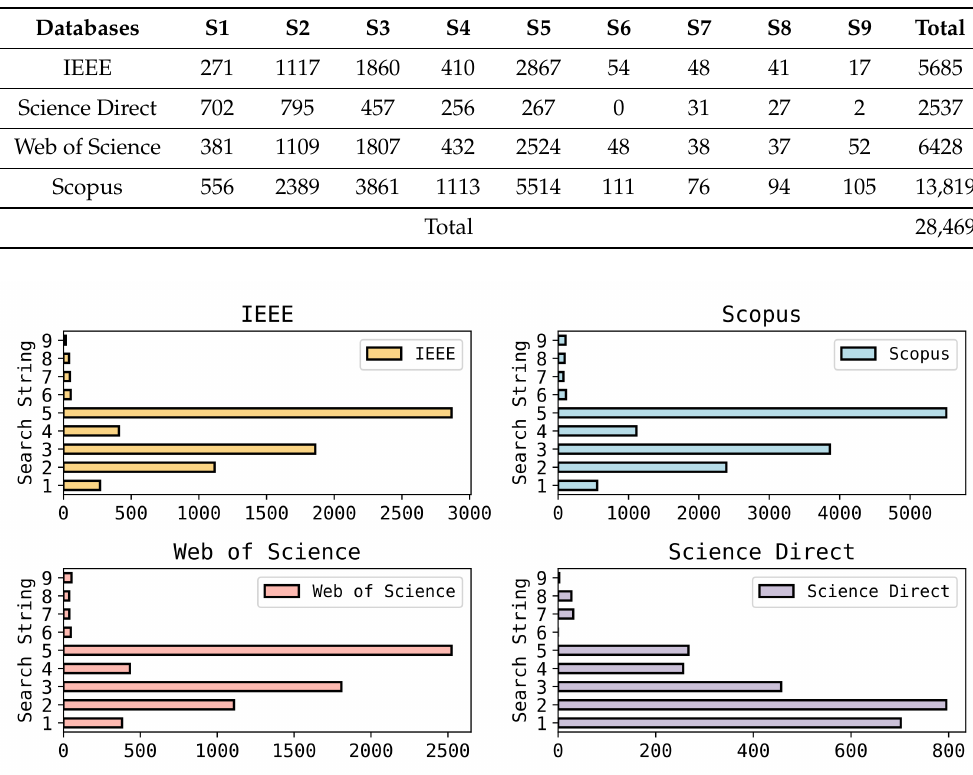
Figure 4. Search string results on